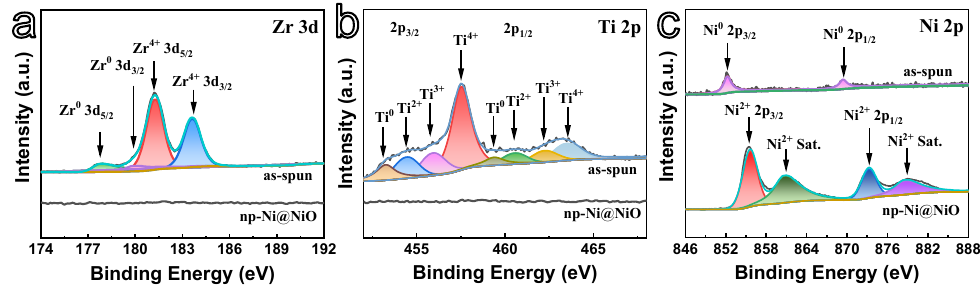
Figure 2. ( a ) Zr 3d XPS spectra; ( b ) Ti 2p XPS spectra; ( c ) Ni 2p XPS spectra for the as-spun Ni 40 Ti 40 Zr 20 and the